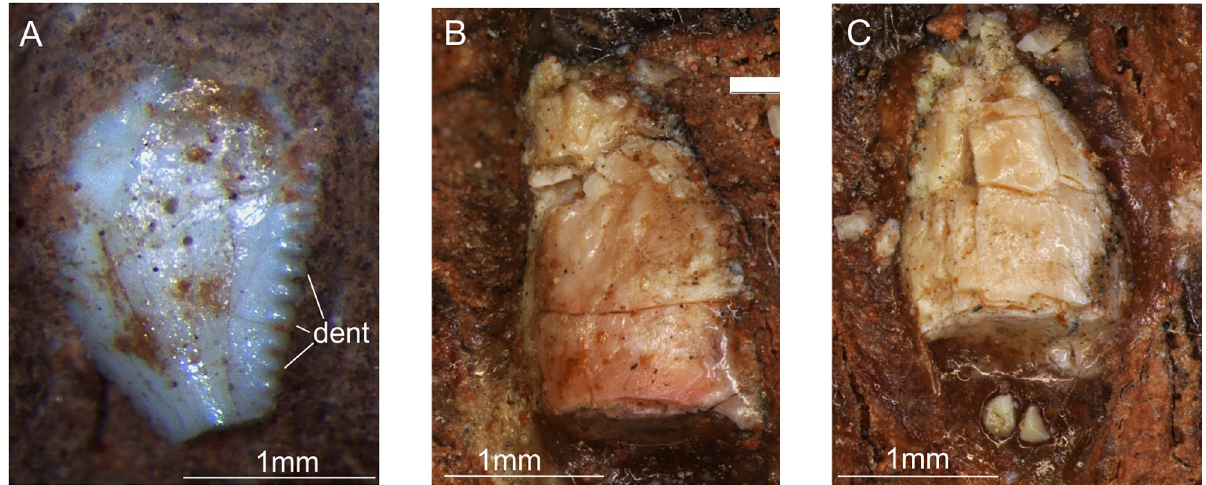
Fig 11. Dentition of Saturnalia tupiniquim . A. Sixth (from anterior to posterior) of the preserved teeth in the left maxilla of the specimen MCP- 3845-PV of Saturnalia tupiniquim in labial view. B and C. Fifth and third (from anterior to posterior) of the preserved teeth in the left dentary of the specimen MCP-3845-PV of Saturnalia tupiniquim in lingual view. Abbreviations: dent—denticles.